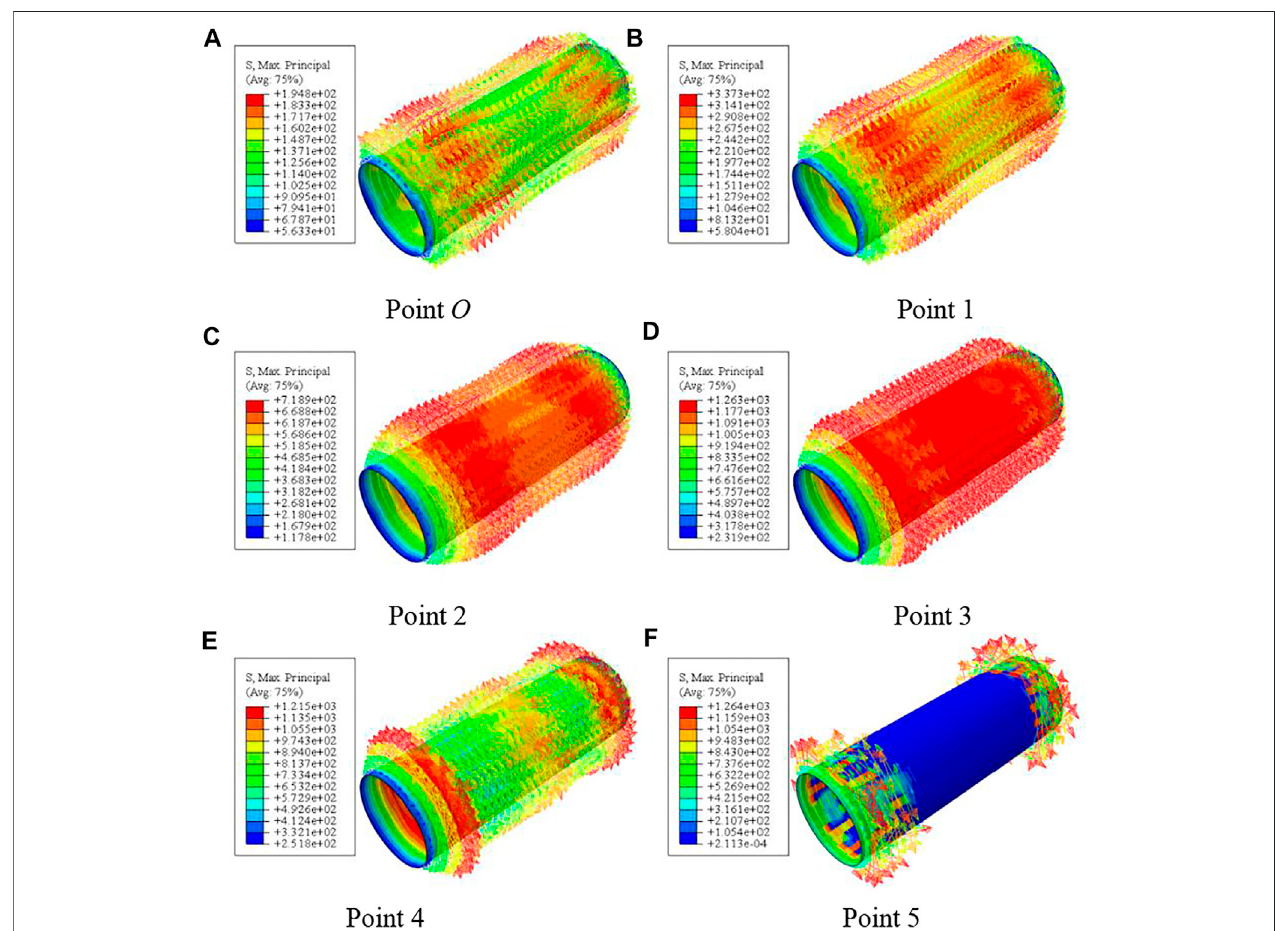
FIGURE 22 | Stress distribution of transverse CFRP. (A – F) Stress distribution of transverse CFRP at different 0 – 5 points.